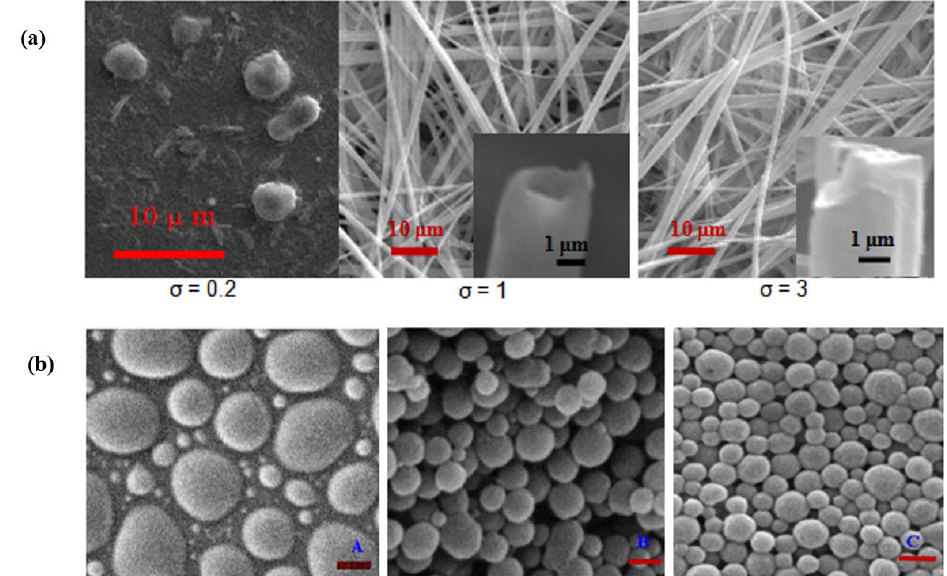
Figure 3. ( a ) Scanning electron micrographs of the diphenylalanine (FF) nanostructures at various degrees of super-saturations; ( b ) SEM images of chitosan-sodium tripolyphosphate/vitamin C nanoparticles at different chitosan molecular weights of 450 ( A ), 110 ( B ), and 65 kDa ( C ), scale bar corresponds to 200 nm; reprinted with permission from [64].